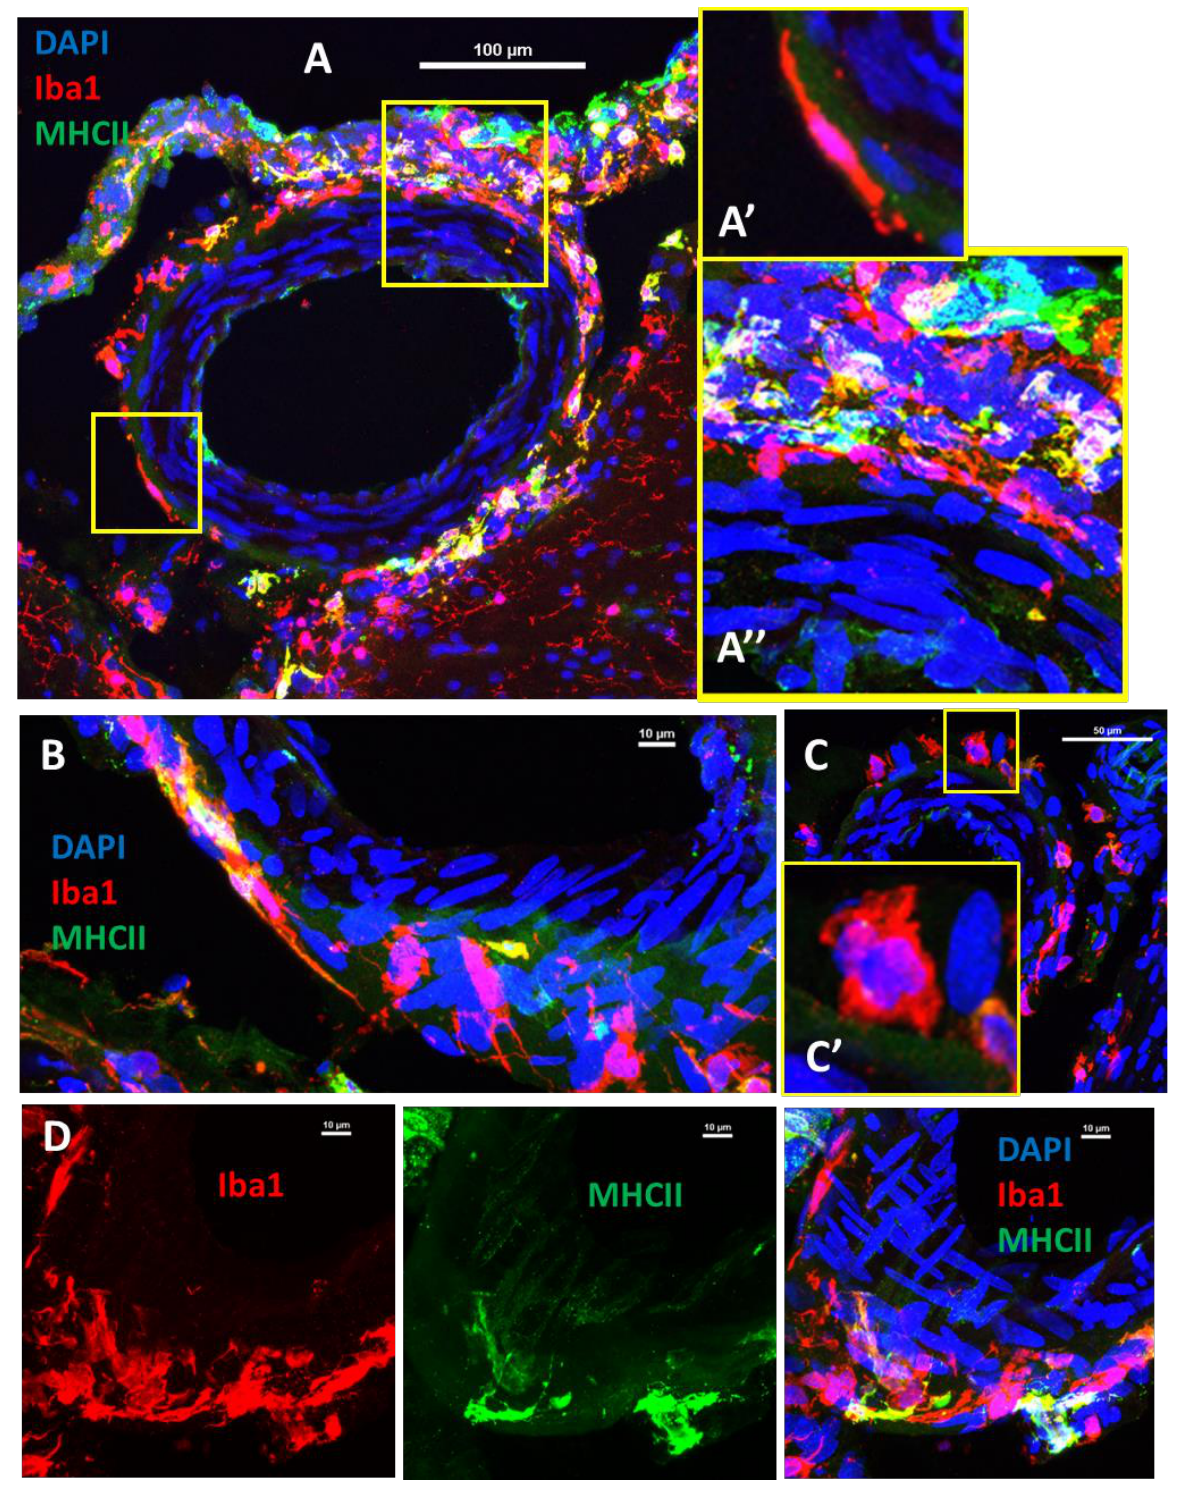
Figure 6. Representative images showing different PVAM morphology. Some PVAMs are elongated around the circumference of the pial vessel’s cross -section ( A’ and A’’ ) while others appeared to run perpendicular to the smooth muscle cells ( B ). Other cells appeared more amoeboid and round with greater distance between them ( C and C’ ). ( D ) Additional PVAMs in close proximity to each other around the pial vessels. Red = Iba1, Green = MHC-II, Blue = DAPI. Scale bar in A = 100 µm and B-D = 10µm. SD — Sprague Dawley, DS — Dahl-SS/Jr.